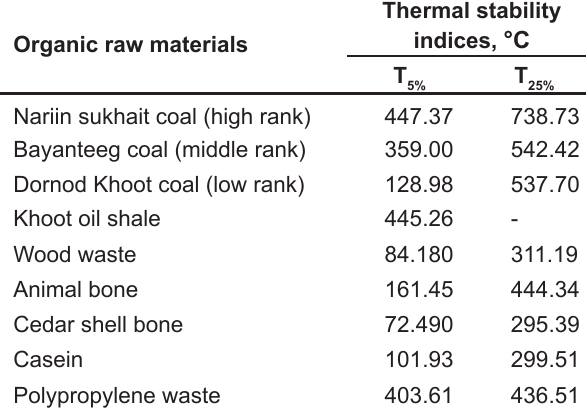
Thermal stability